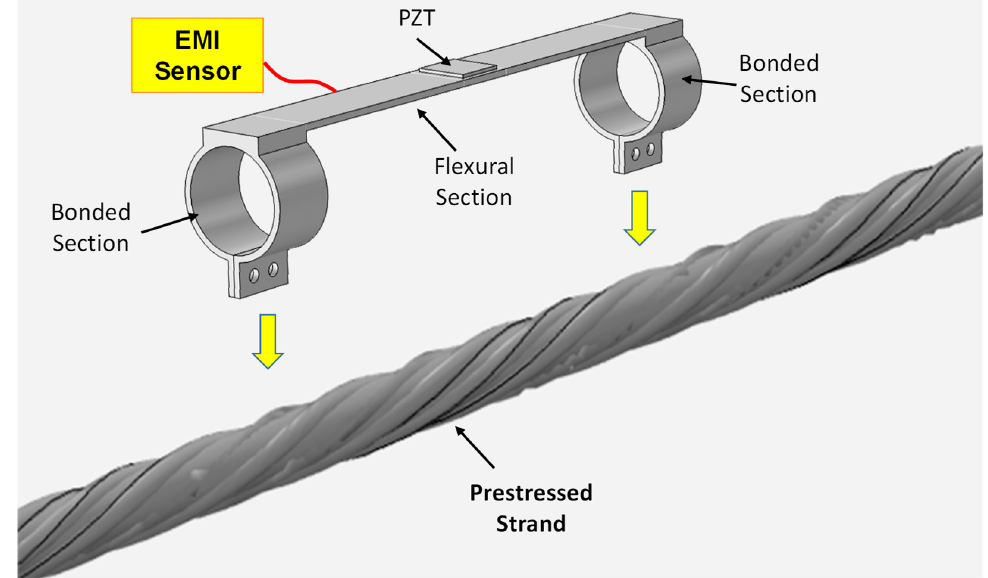
Figure 2. The conceptual design of the piezoelectric-based smart